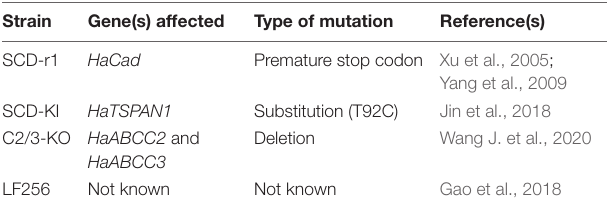
TABLE 1 | Genetic basis of resistance to Cry1Ac in four strains of H. armigera. Strain Gene(s) affected Type of